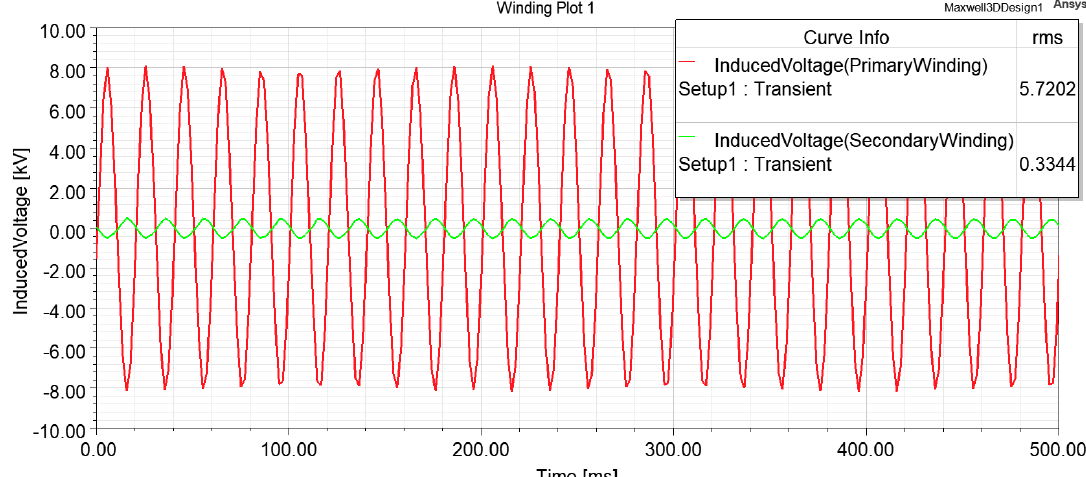
Figure 9. The RMS values of the optimized 2.6 mm thick BSST primary (red line) and secondary (green line) copper windings, induced voltage.